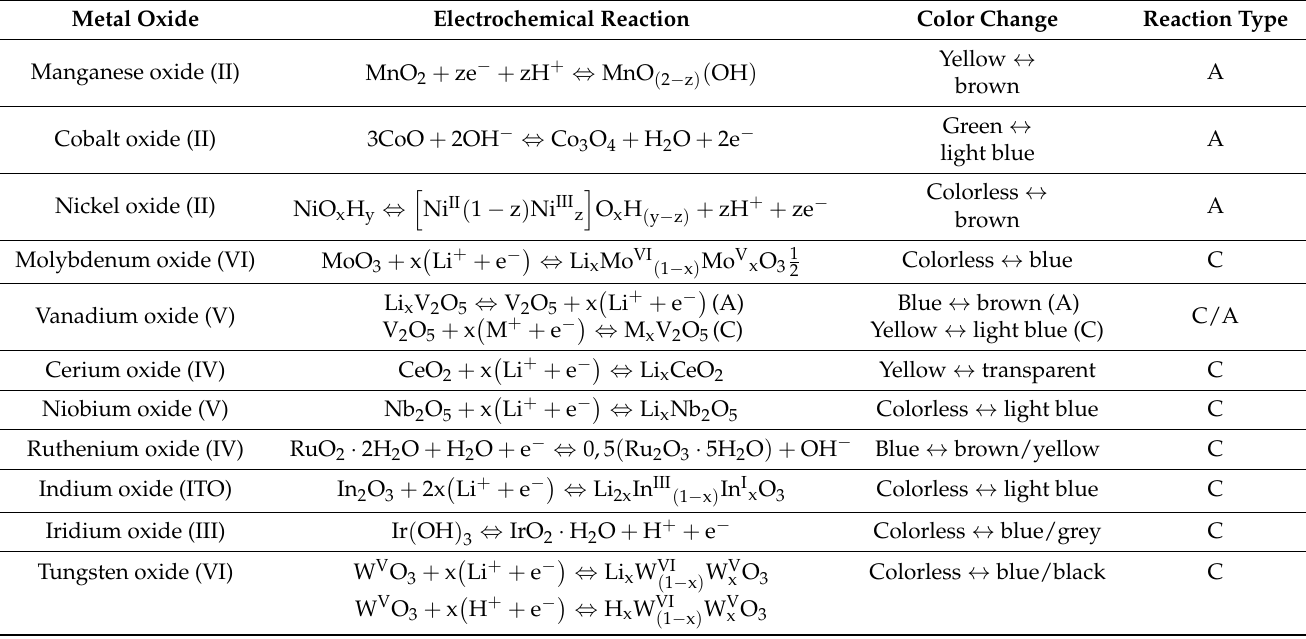
Table 6. Electrochemical reactions of certain